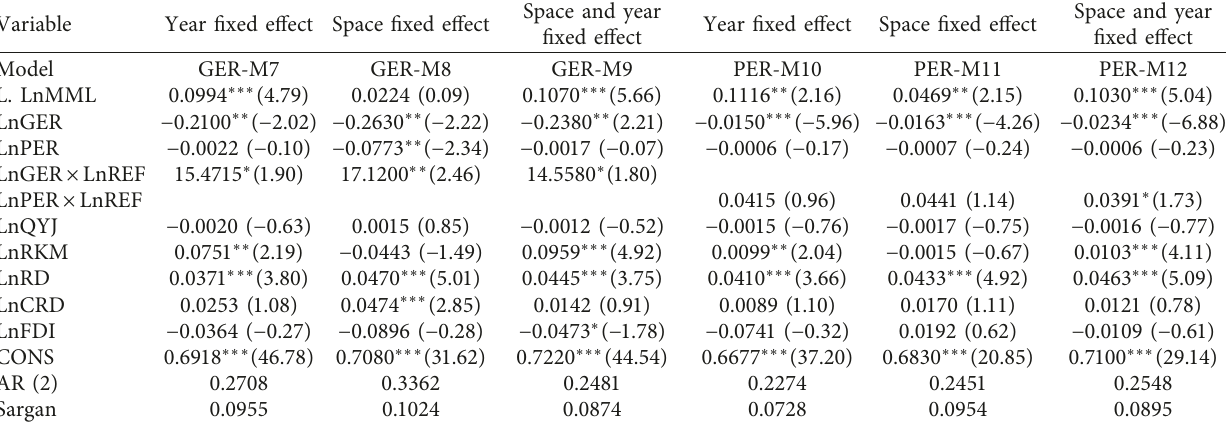
Table 5: Regression results of nonlinear effect model (threshold variable: